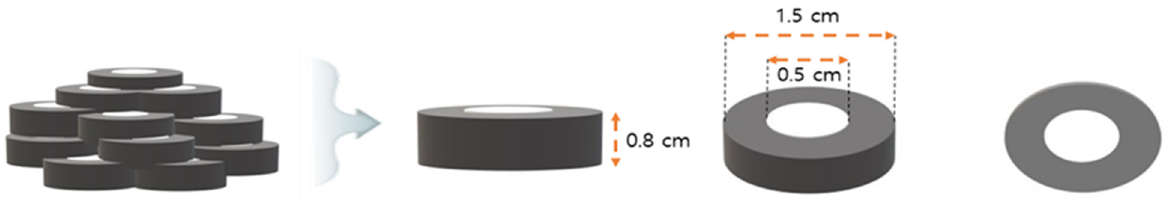
Figure 11. Four steps of the CO 2 methanation process.